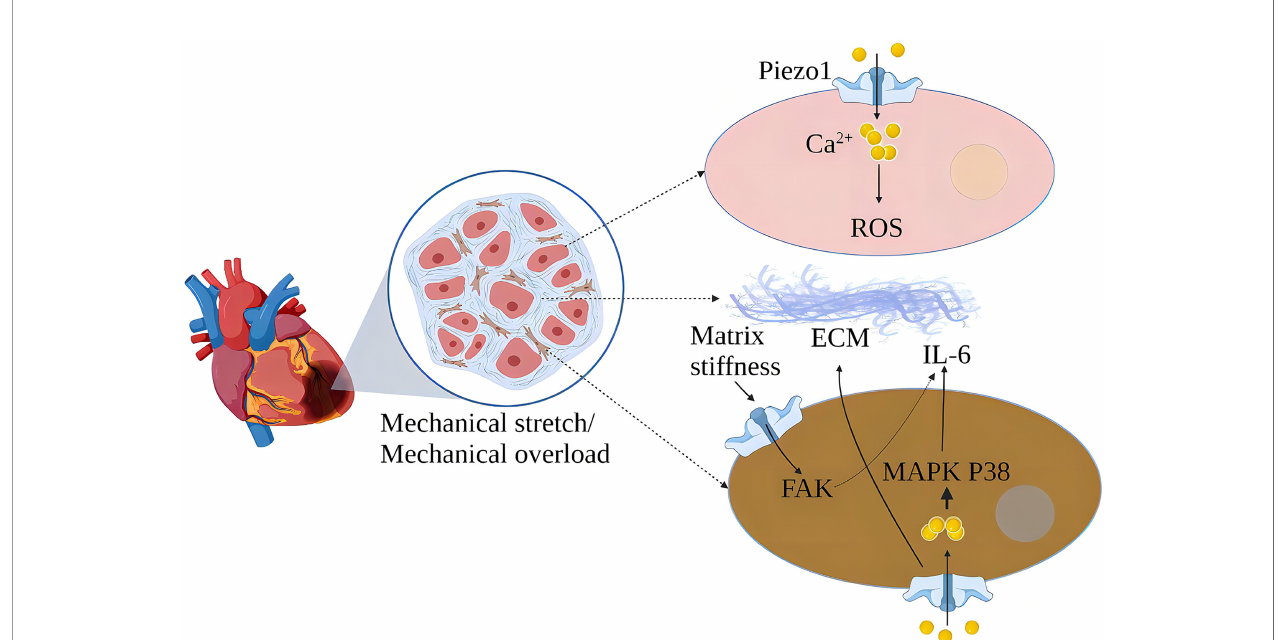
FIGURE 5 | Schematic diagram of the mechanism of action of Piezo1 in myocardial fi brosis. Piezo1 helps cardiomyocytes transduce mechanical stretch into intracellular Ca 2+ signaling and ROS signaling, and mechanical overload leads to increased Piezo1 expression in cardiomyocytes, ultimately leading to cardiomyopathy. In vitro , mechanical stretch-induced fi broblast Piezo1 opening and promoted IL-6 mRNA expression through the MAPKP38 signaling pathway. Mechanical stretch induces fi broblasts to increase ECM secretion, and increased matrix stiffness may further upregulate Piezo1 expression and promote fi brosis